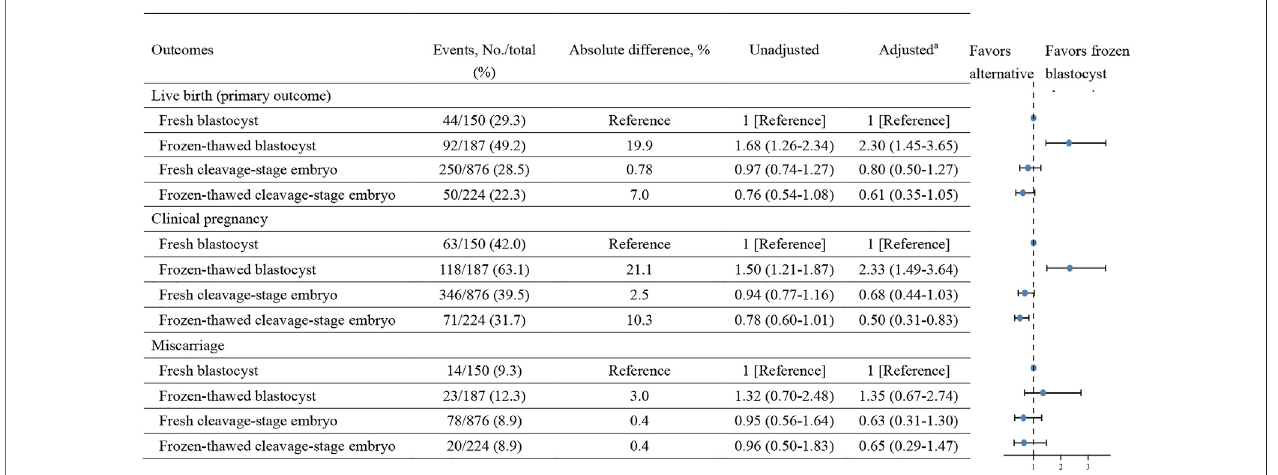
Frontiers in Cell and Developmental Biology |